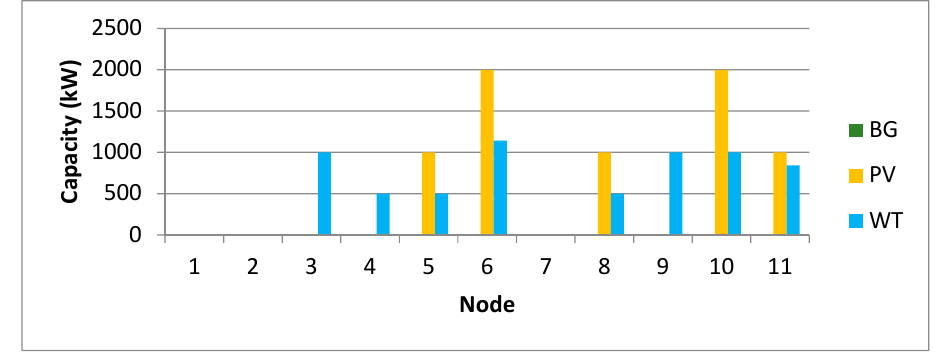
Figure A6. Capacity structure for 50% share of energy from RES in total demand with sizing and allocation of RES and ES.